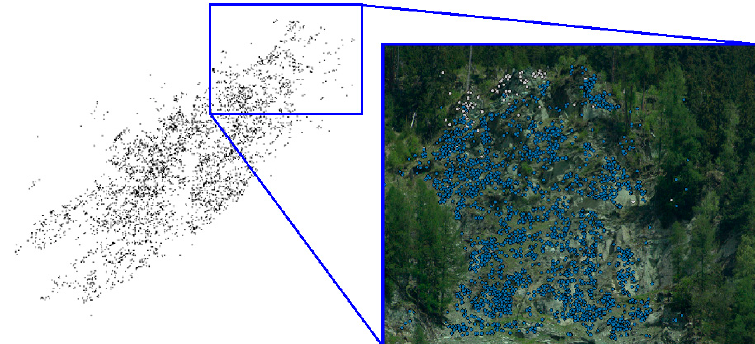
Figure 4. Dense point cloud generated by SfM processing with a focus on the of Ingelsberg’s landslide Head Area.